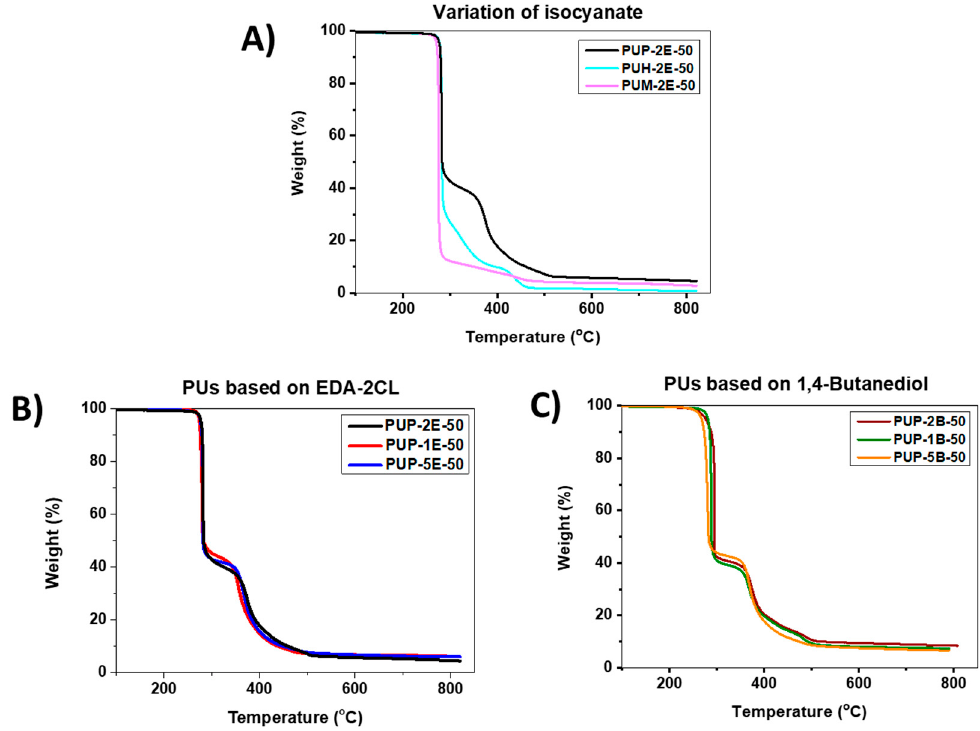
Figure 5. TGA curves of synthesized polyurethanes under inert atmosphere. ( A ) Poly(Ester-urethane)s varing the isocyanate. ( B ) PABA-Polyurethanes with hydrolysable chain-extender. ( C ) PABA-Polyurethanes using 1,4-butanediol as chain-extender.